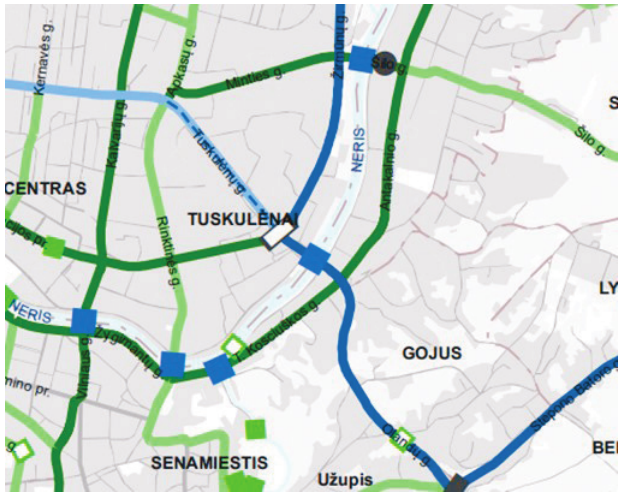
Figure 2. Street categories according to the master plan of